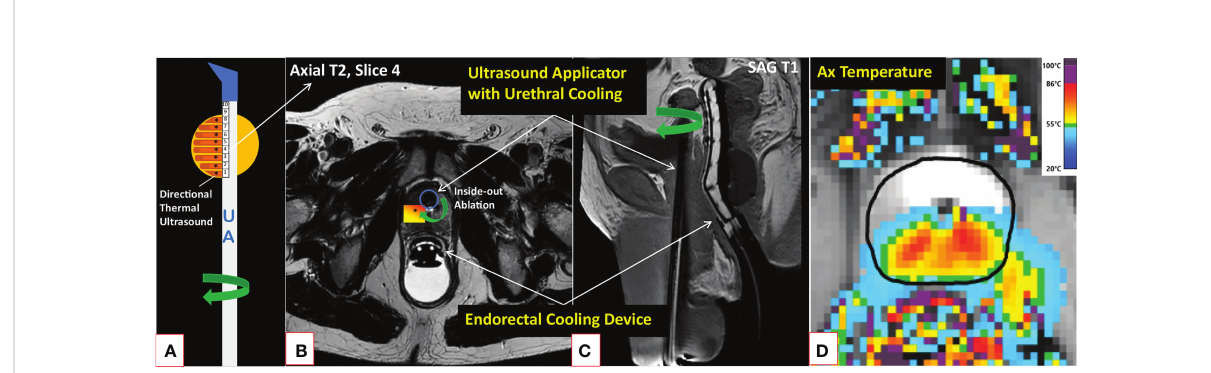
FIGURE 1 Description of the TULSA technology. MRI-guided TULSA is a minimally invasive ablation technique delivering directional high-intensity ultrasound energy (*) to the prostate (yellow circle) using a transurethral rotational UA comprised of 10 independently controlled ultrasound elements (A) . By actively cooling both the urethra and rectum throughout the ablation, TULSA protects these structures from thermal injuries (B, C) . Real-time MRI-thermometry is continuously acquired during the ablation to automatically control the delivered lethal thermal energy by adjusting each ultrasound element ’ s frequency and power and the UA ’ s rotation rate (D) . On the axial maximum temperature image of a patient undergoing lesion-targeted TULSA of a posterior peripheral zone tumor (D) , a minimum lethal temperature of 55°C reaches the drawn (black) boundary. Due to prostate swelling caused by the ablation, the catheter is kept in place for weeks after the procedure (see Figure 2 patient case with a suprapubic catheter). MRI, magnetic resonance imaging; TULSA, transurethral ultrasound ablation; UA, ultrasound